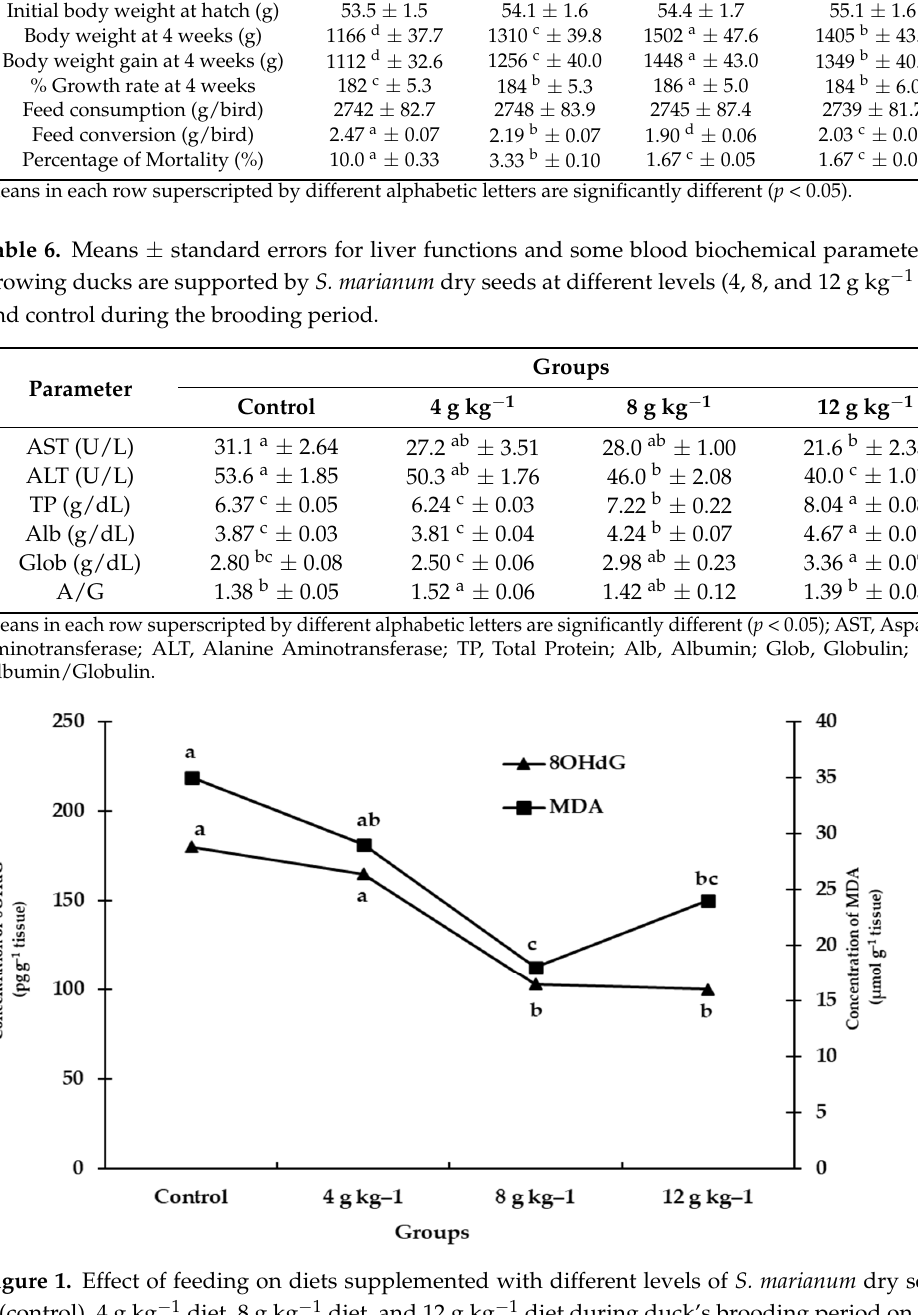
Table 6. Means ± standard errors for liver functions and some blood biochemical parameters of growing ducks are supported by S. marianum dry seeds at different levels (4, 8, and 12 g kg − 1 diet) and control during the brooding period.